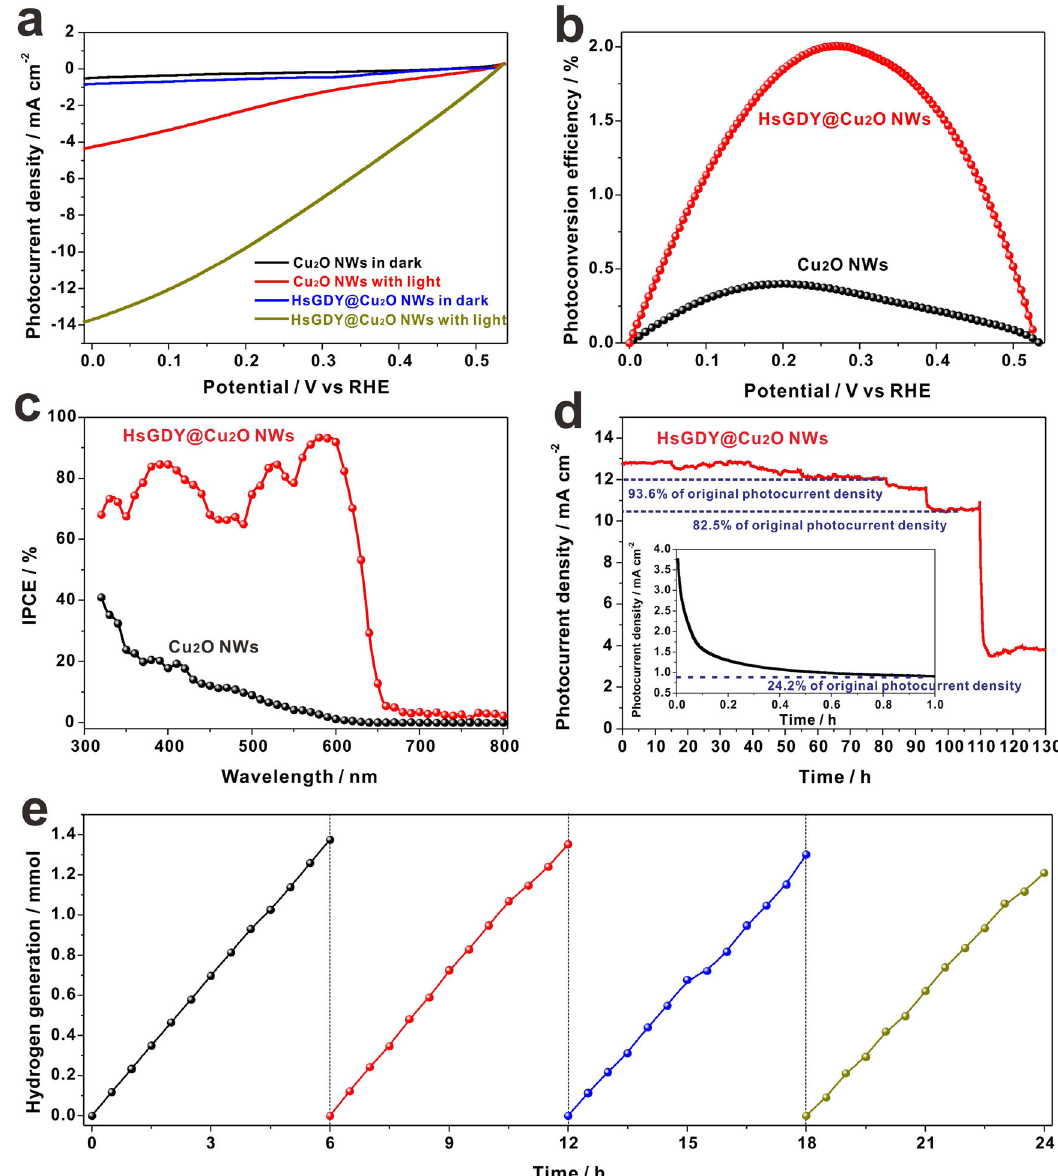
Fig.2|PECwaterreductiononHsGDY@Cu 2 ONWsphotocathode.a LSVplotsof Cu 2 O NWs and HsGDY@Cu 2 O NWs in dark and under illumination of